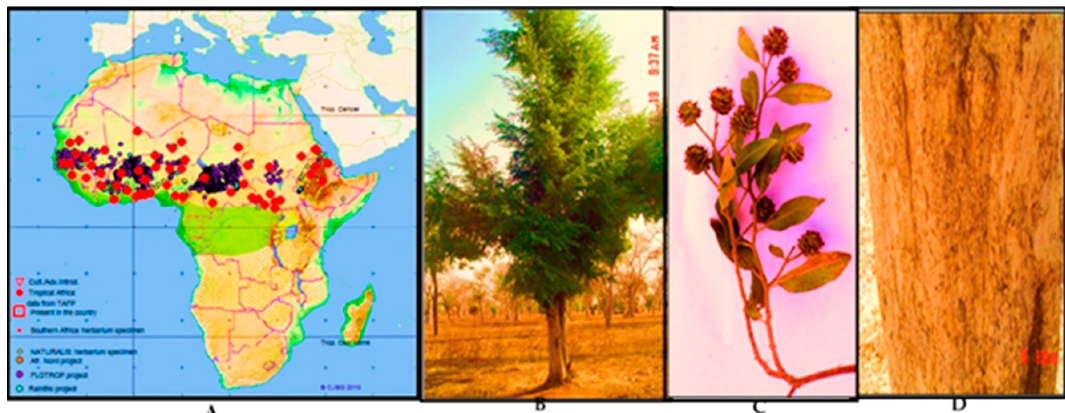
Figure 1. ( A ) Occurrence of Anogeissus leiocarpus in Africa according to various vegetation mapping projects. (TAFP), red dots; Naturalis Herbarium specimen, yellow spots; Africa Nord project, orange spots; FLOTRO project, violet dots (Source: African Plant Database); ( B ) Anogeissus leiocarpa growing in semi-arid and woodland savannah zone in Sudan; ( C ) leaves and flowers; ( D ) scaly bark. Photos: E. Y. A. Salih and H. H. Gibreel 2006.